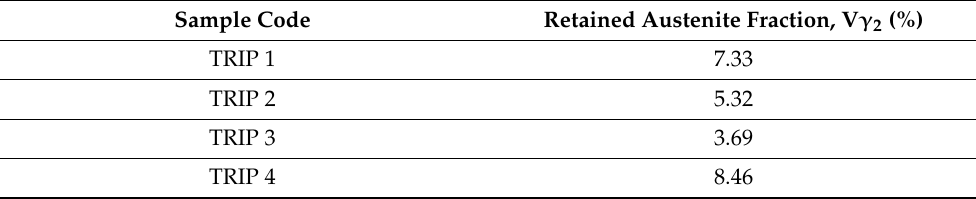
Table 5. Fractions of retained austenite in samples submitted to impact bending tests, V γ 2 .